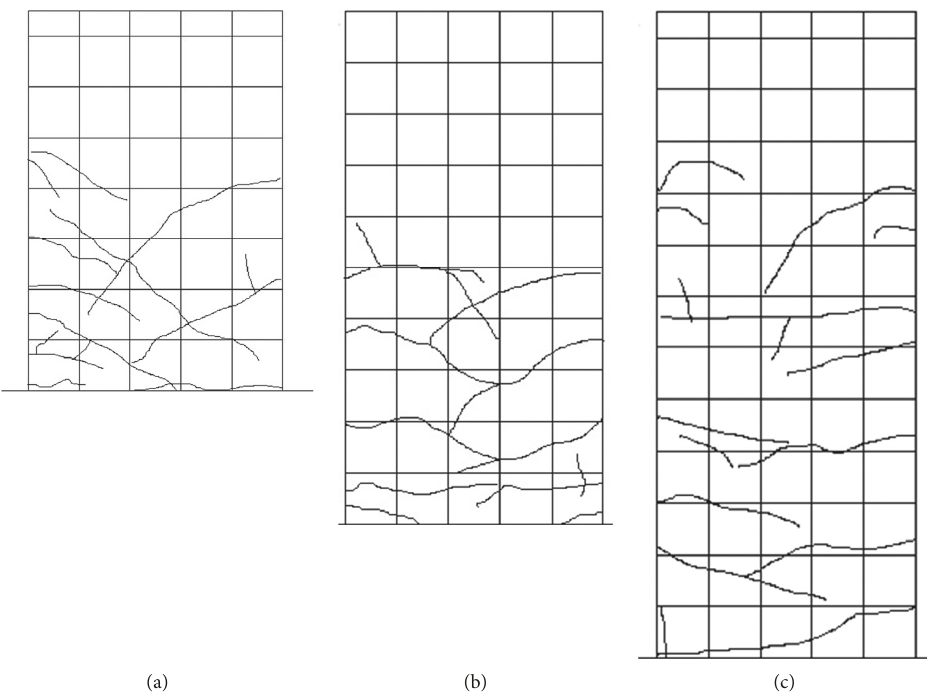
Figure 5: Crack pattern of specimens before concrete crushing. (a) Beam1. (b) Beam2. (c)